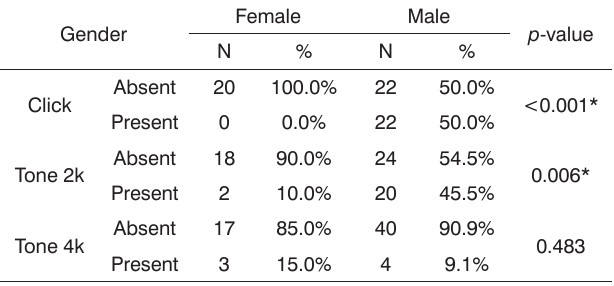
Significance p < 0.05.